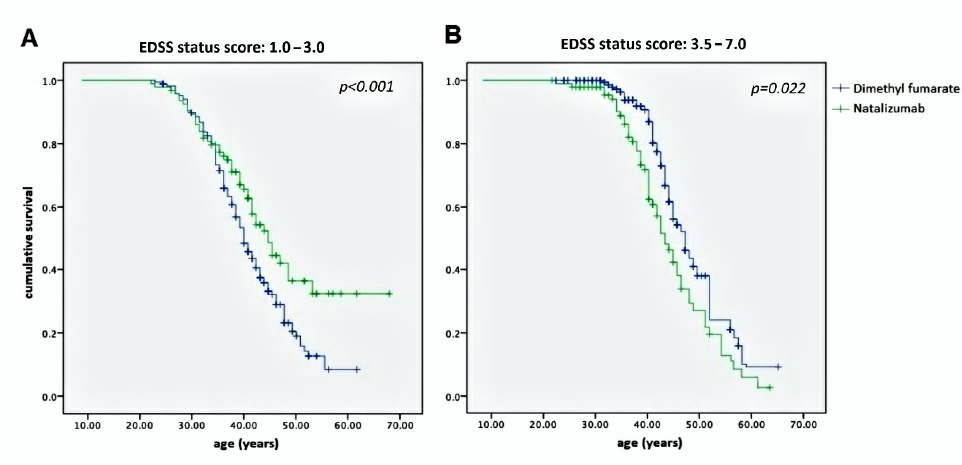
Figure 3. Kaplan–Meier curves representing the proportion of patients with an EDSS status score of 1.0–3.0 ( A ) and 3.5–7.0 ( B ) according to age in both the NTZ- and DMF-treated MS study populations. The highest curve in ( A ) represents the better ability over time of NTZ to maintain the patients at a low grade of disability; the highest curve in ( B ) represents the better ability over time of DMF to stabilize the EDSS in patients that reached a high grade of disability. EDSS—Expanded Disability Status Scale; NTZ—Natalizumab; DMF—Dimethyl fumarate.